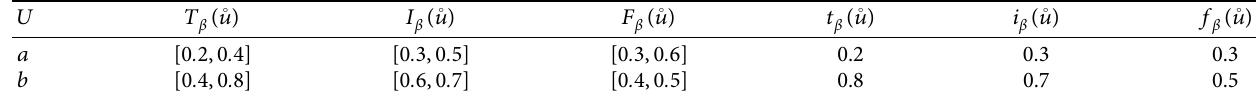
Table 4: External neutrosophic cubic set β of U.